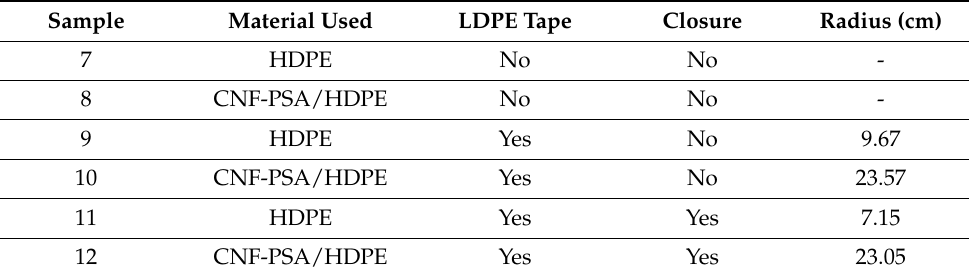
Table 3. Summary of warping measurements of HDPE and composite of 10 wt.% of CNF PSA/HDPE in the notched model.